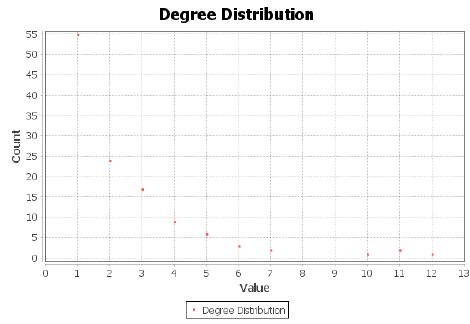
Figure 11. Degree Distribution in Network Structure.